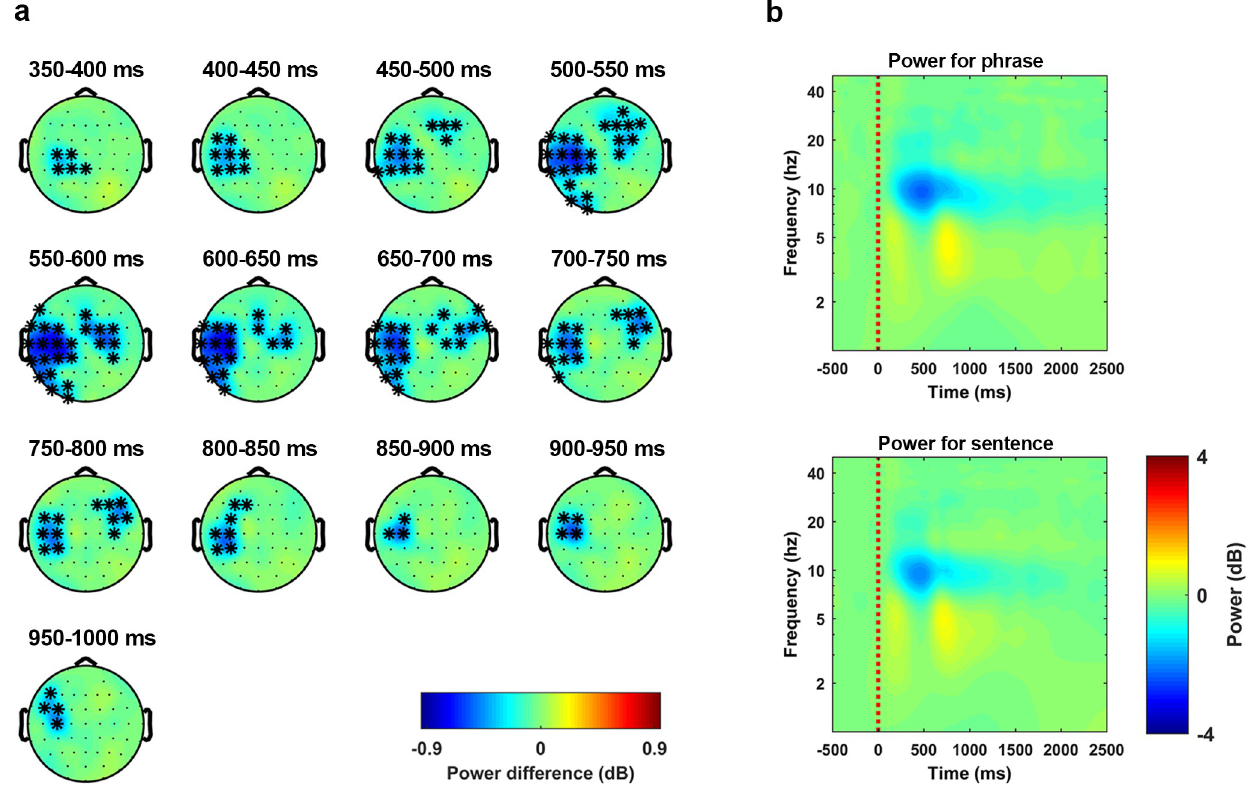
Fig 5. Alpha-band inhibition suggests a separation between phrases and sentences. Statistical analysis on the induced activity was conducted using a nonparametric cluster-based permutation test (1000 times) on a 1000-ms time window, which started at the audio onset and over the frequencies from 7.5 Hz to 13.5 Hz. The results indicated that the power was higher for sentences than phrases ( p < 0.01 �� , 2-tailed). (a) The temporal evolution of the cluster that corresponds to the discrimination effect. The activity was drawn by using the averaged induced power of the phrases minus the averaged induced power of the sentences. The topographies were extracted in steps of 50 ms. (b) Induced power averaged over all the sensors in this cluster. The upper panel and the lower panel show the induced power of the phrases and the sentences, respectively.